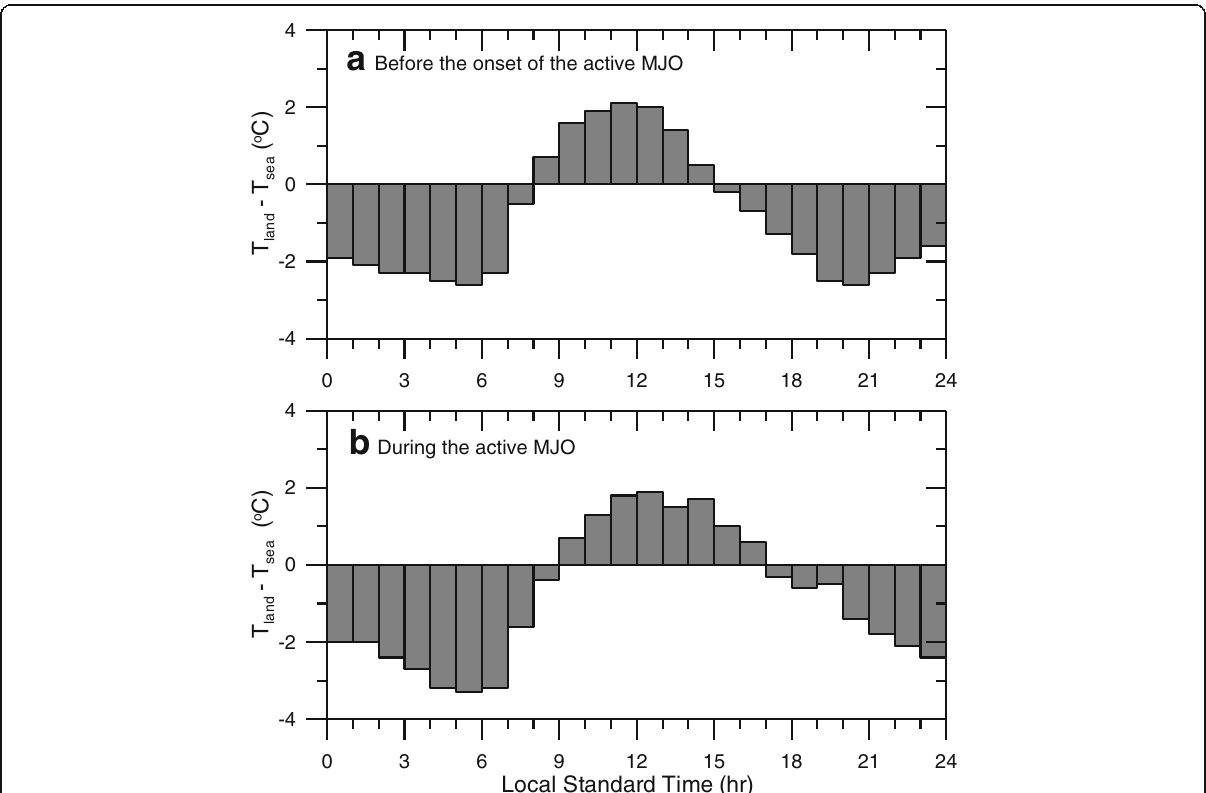
Fig. 8 A comparison of the diurnal changes in surface air temperature differences between the land and sea, a before the onset of the active MJO averaged over 23 November to 12 December and b during the active MJO averaged over 13 to 17 December